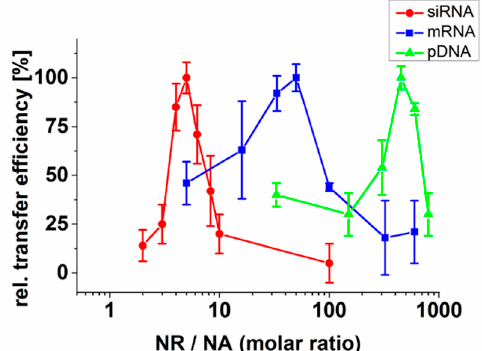
Figure 1. Influence of nucleic acid size on transfer efficiency. Nucleic acids (NA) with different sizes (anti-GFP siRNA, mRNA (GFP-mRNA), and GFP-expression plasmid (pDNA)) were complexed with the neutralization reagent (NR) protamine before incubation with FLs. Depending on the NR/NA molar ratio, NA transfer efficiencies were determined as the number of GFP positive cells after mRNA and pDNA transfer. For siRNA, the knockdown efficiency of eGFP–mRNA was determined by qRT–PCR. Maximum transfer efficiencies were set to 100% for best visibility. Values are given as mean with standard deviation of three independent measurements. NR = neutralization reagent; NA = nucleic acid.